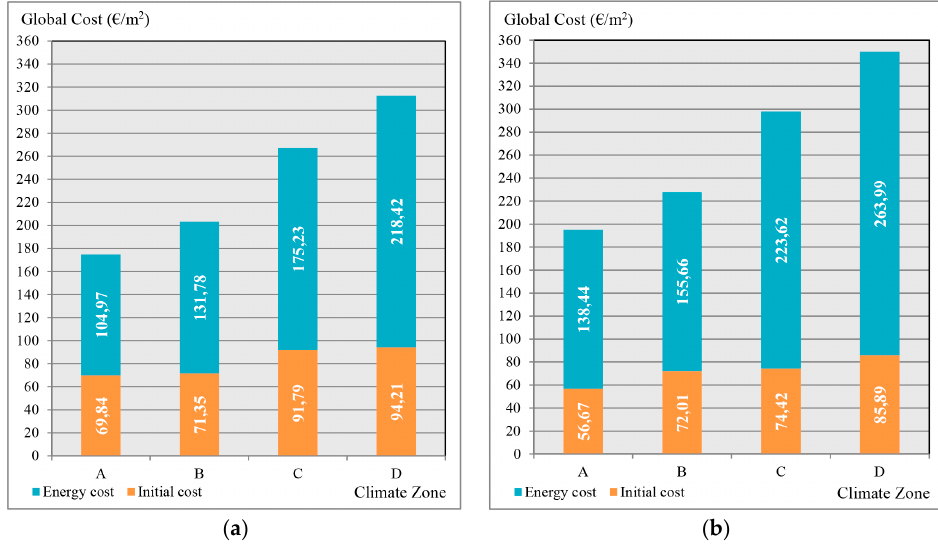
Figure 3. Global cost composition in present value for the Basic ( a ) financial and ( b ) macroeconomic calculation in the four climate zones of Greece.